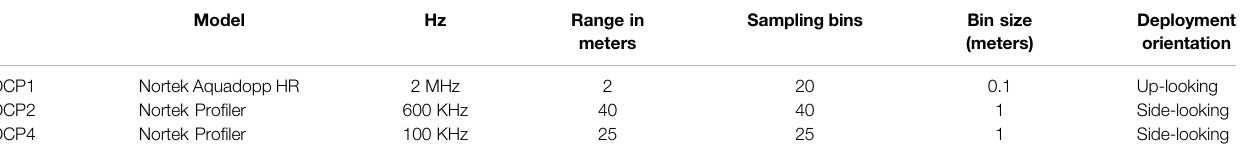
TABLE 2 | ADCP con fi guration.